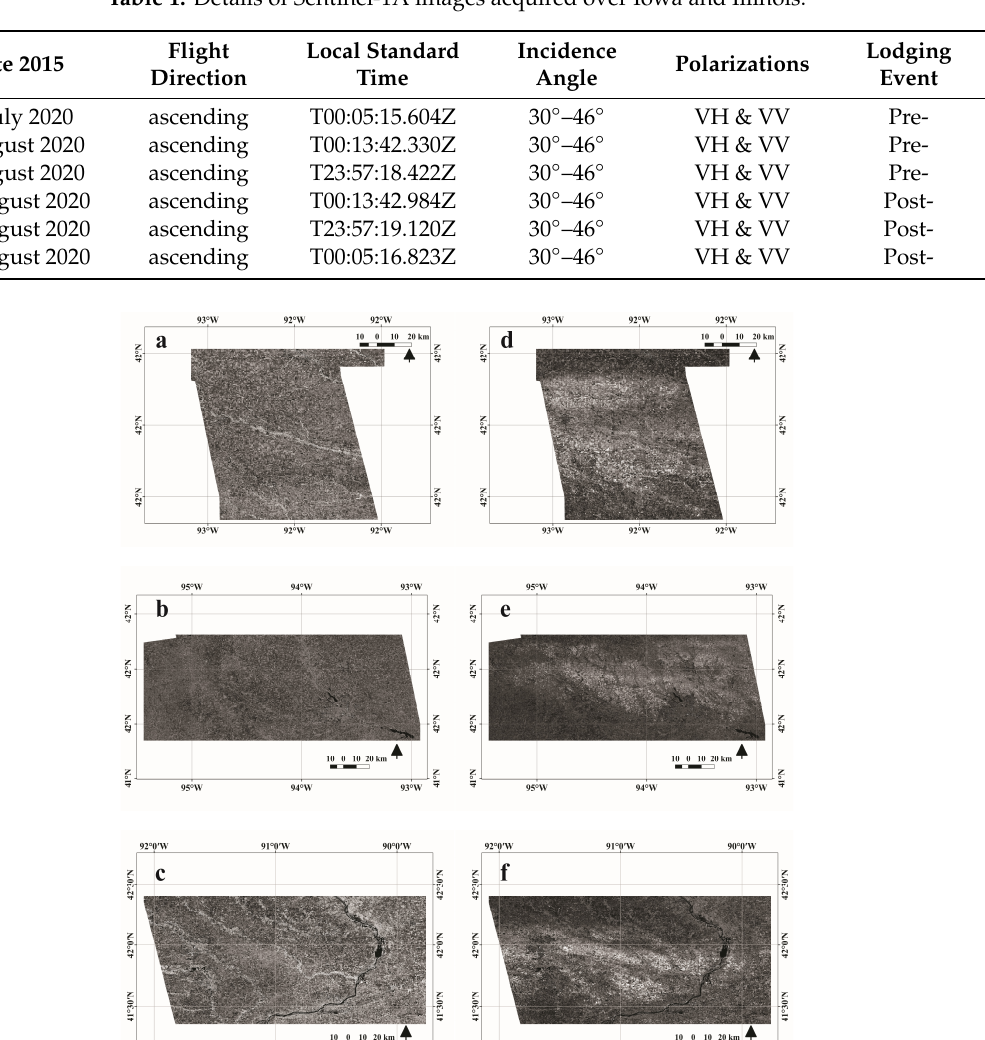
Figure 3. Pre-lodging images acquired on ( a ) 29 July 2020; ( b ) 3 August 2020; and ( c ) 4 August 2020. Post-lodging images acquired on ( d ) 22 August 2020; ( e ) 15 August 2020; and ( f ) 16 August